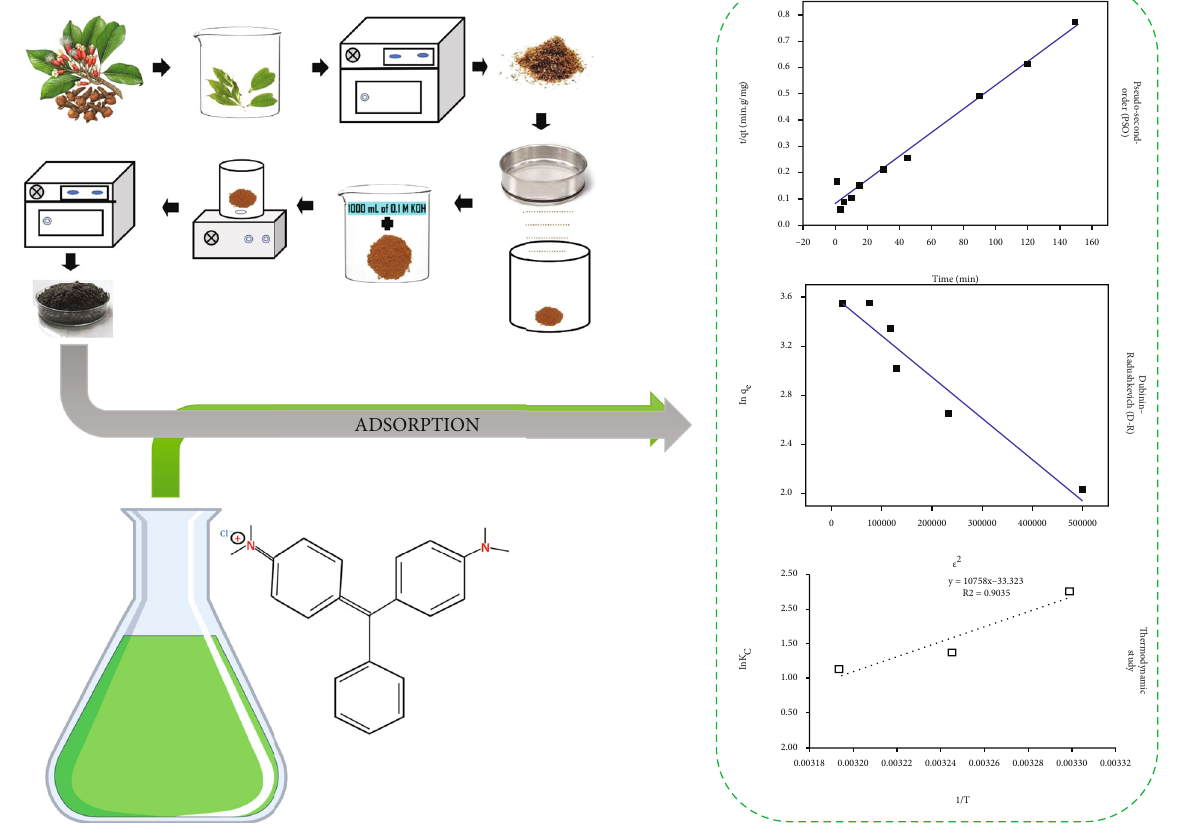
Figure 2: The outline of the study.